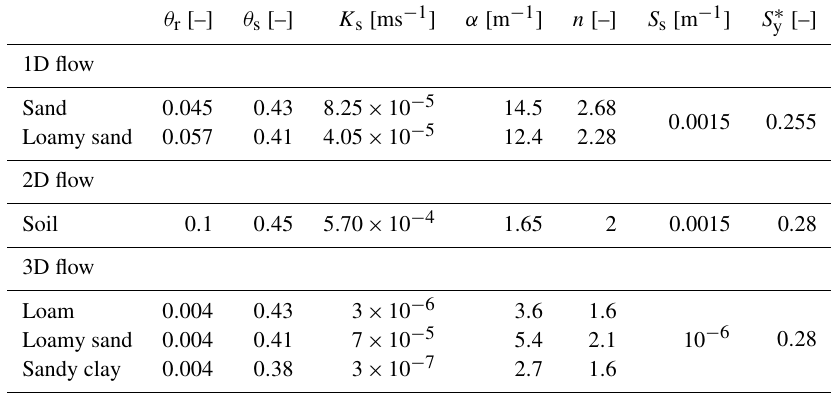
Table 2. Soil hydraulic parameters for the three test cases for Parflow and the coupled model.